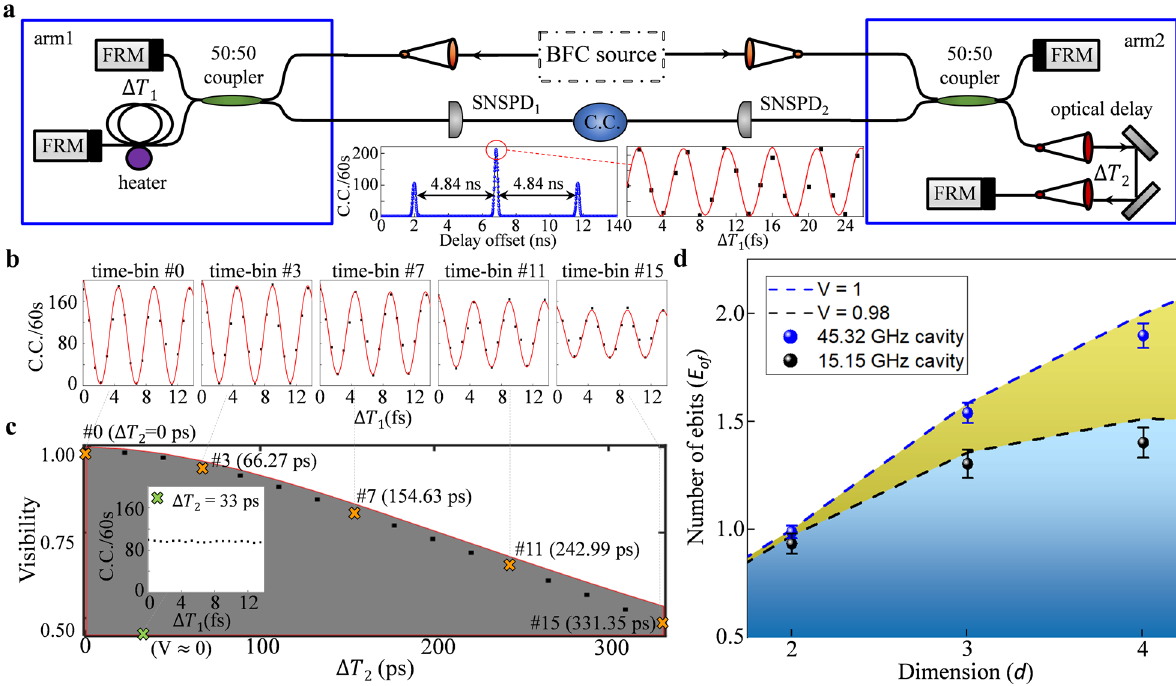
Fig. 4 Measured energy – time Franson revival interferometry of the high-dimensional biphoton frequency comb. a Experimental Franson interference setup. Faraday mirrors (FRMs) compensates the stress-birefringence of the single-mode fi ber interferometers. A compact optical delay line is used in the longer path of arm2 ( Δ T 2 ) to provide the tunability in optical delay up to 360 ps. Left inset: temporal two-photon waveforms (in blue) of Franson interferometry for constructive interferences. Right inset: zoom-in observed phase-sensitive interference fringe (in red) versus the relative optical delay introduced by the heater in long path of arm1 ( Δ T 1 ). The observed Franson visibility is 96.1%, or 99.07% after subtracting the accidental coincidence counts. b , c Witnessed visibility of the Franson revival interference fringes. The coincidence counts in Franson interference experiments are selected for 0 (time-bin 0), 3, 7, 11, and 15 (time-bin 15) round-trip times of the 45.32 GHz fi ber cavity (orange crosses; each round-trip time-bin at 22.09 ps), matching well with theoretical fringe envelope (red solid line; also further detailed in Supplementary Discussion II). Also included with the green cross in panel c inset is the Franson interference, when measured away from the integer time bins (such as at Δ T 2 = 33 ps), with no observable interference fringes. d Lower bounds for the entanglement of formation (number of ebits) versus dimension d , in reconstructing the density matrix. Time – frequency entanglement containing up to 1.89 ± 0.03 ebits for the 45.32 GHz BFC out of the maximum 2 ebits when d = 4. For the 15.15 GHz BFC, the Franson interference recurrences extract 1.40 ± 0.05 ebits out of the maximum of 2 ebits (also detailed in Supplementary Discussion